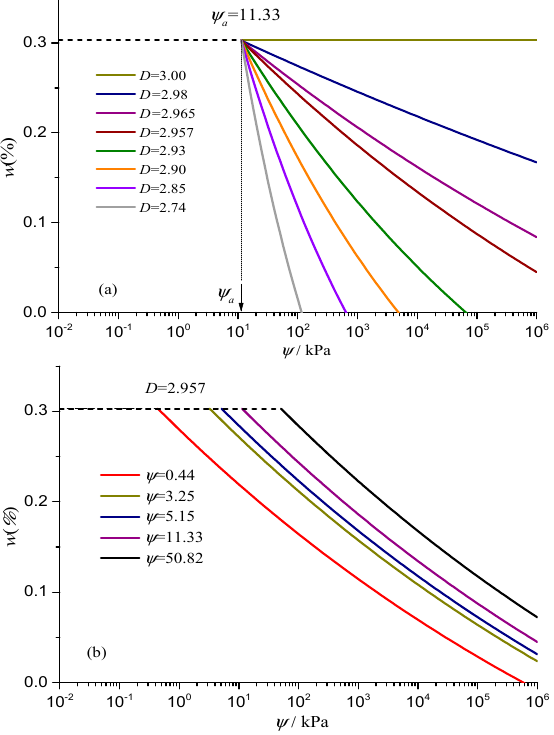
Figure 2. The influence of parameters on SWCC: ( a ) fractal dimension, ( b ) air-entry value